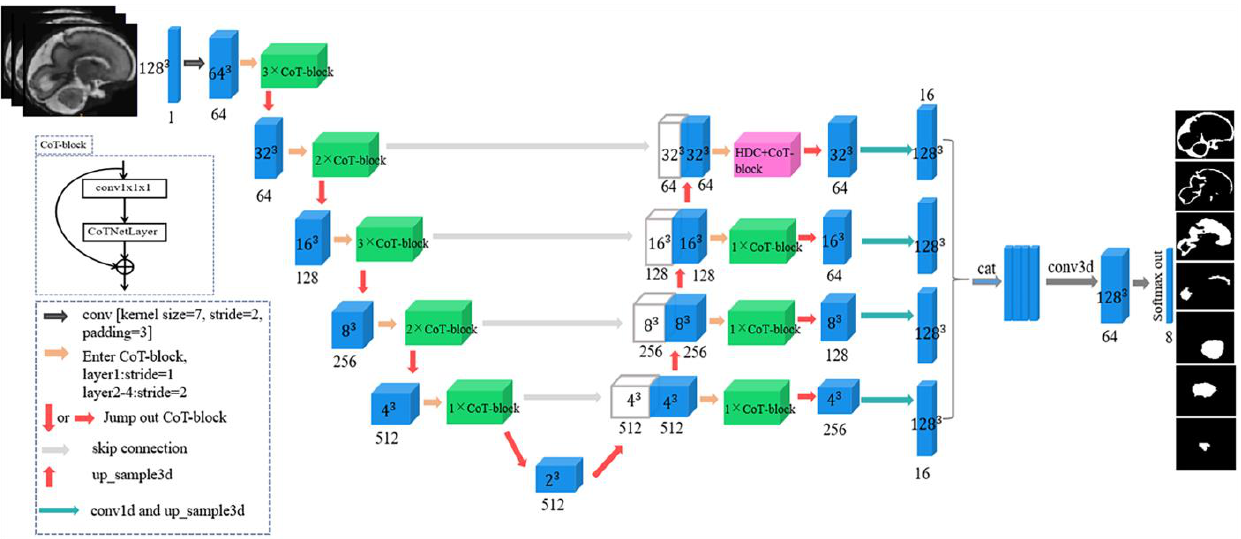
Figure 2. Network architecture: the network consists of a backbone network, which is composed of an encoder – decoder architecture, skip connection, and feature combination.